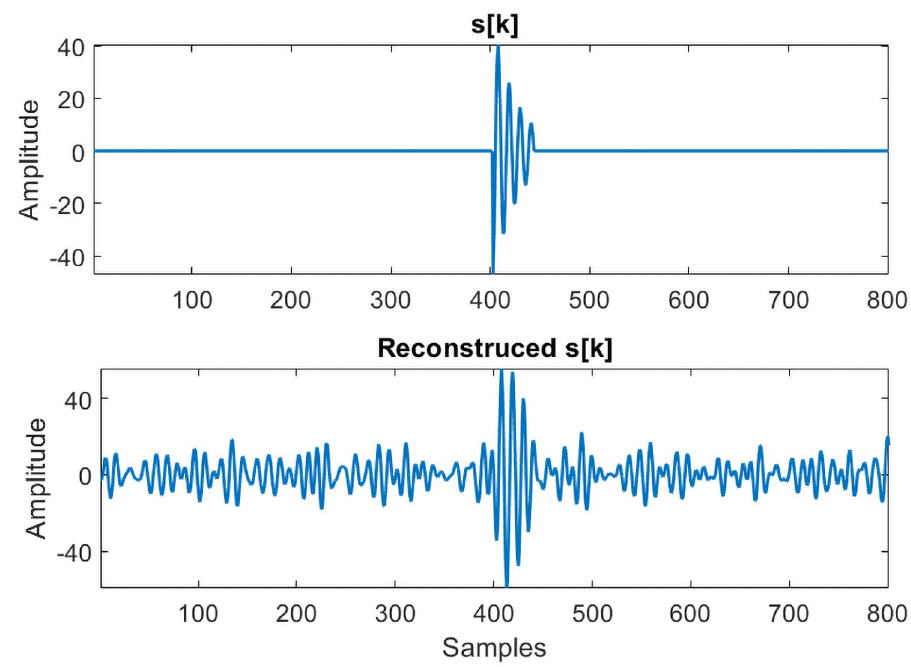
Fig 6. Reconstructed signal. Amplitude of the reconstructed signal is smaller than the original s [ k ].